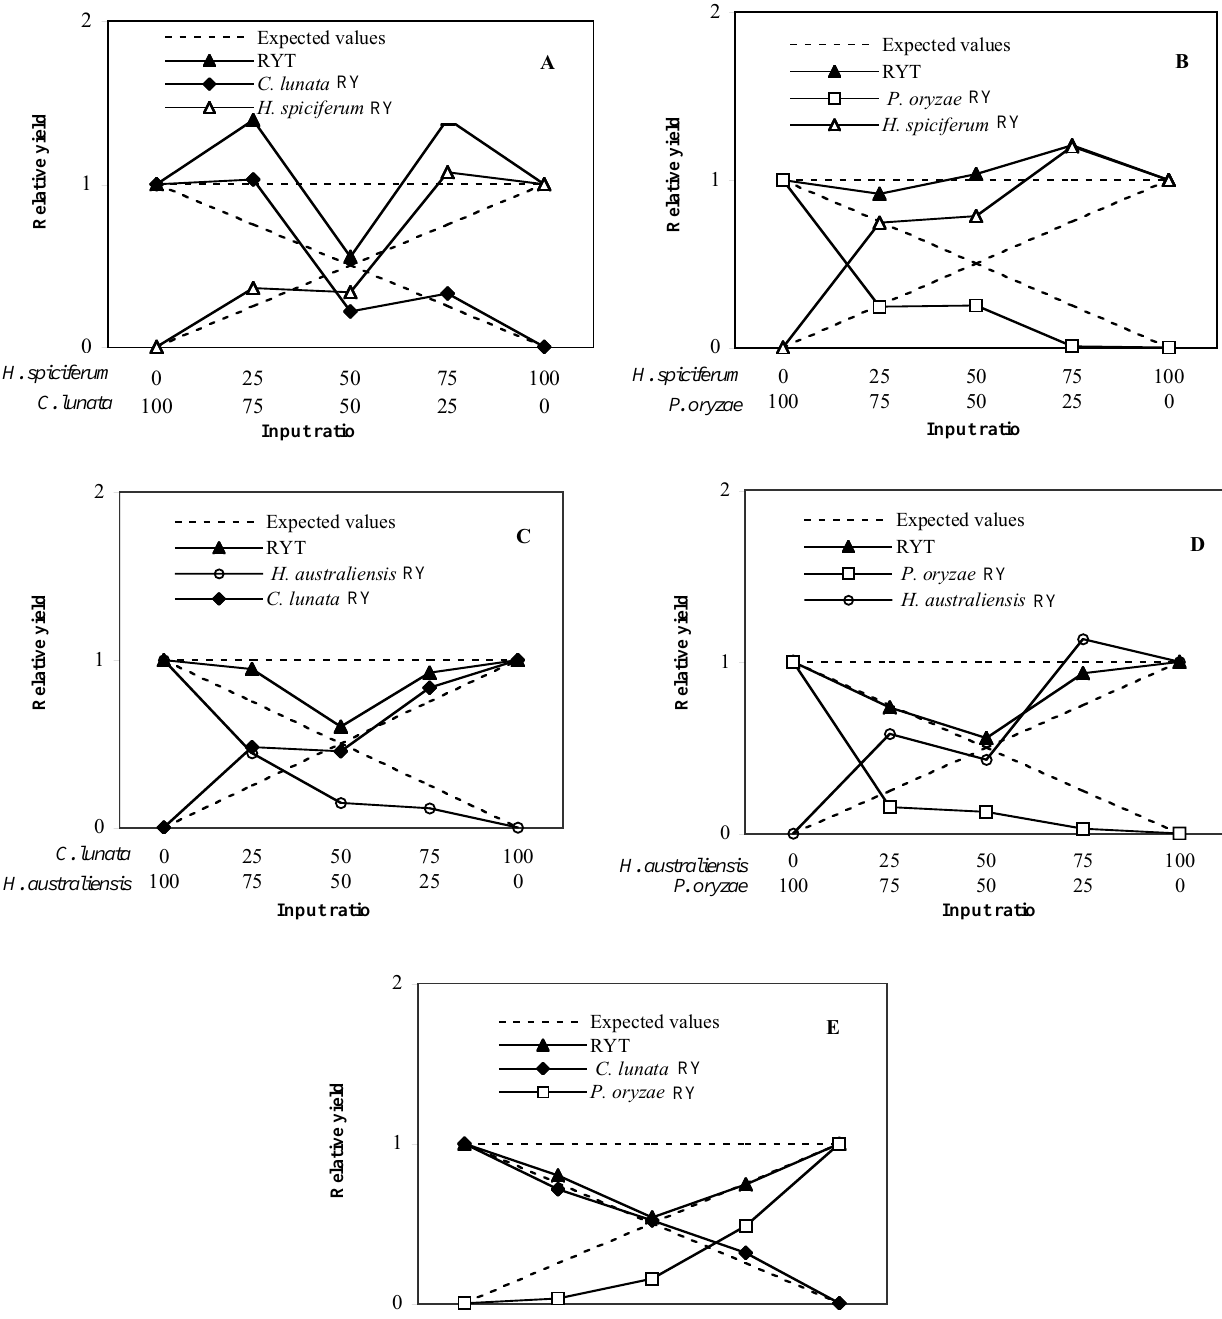
Fig. 3. Relative conidia production on rice leaves inoculated with H. spiciferum, H. australiensis, C. lunata, P. oryzae , alone and in combination, resulting from varied input ratio. RYT, relative yield total; RY, relative yield of each species; Expected values (dotted lines) are reference values indicating equal inter- and intraspecific